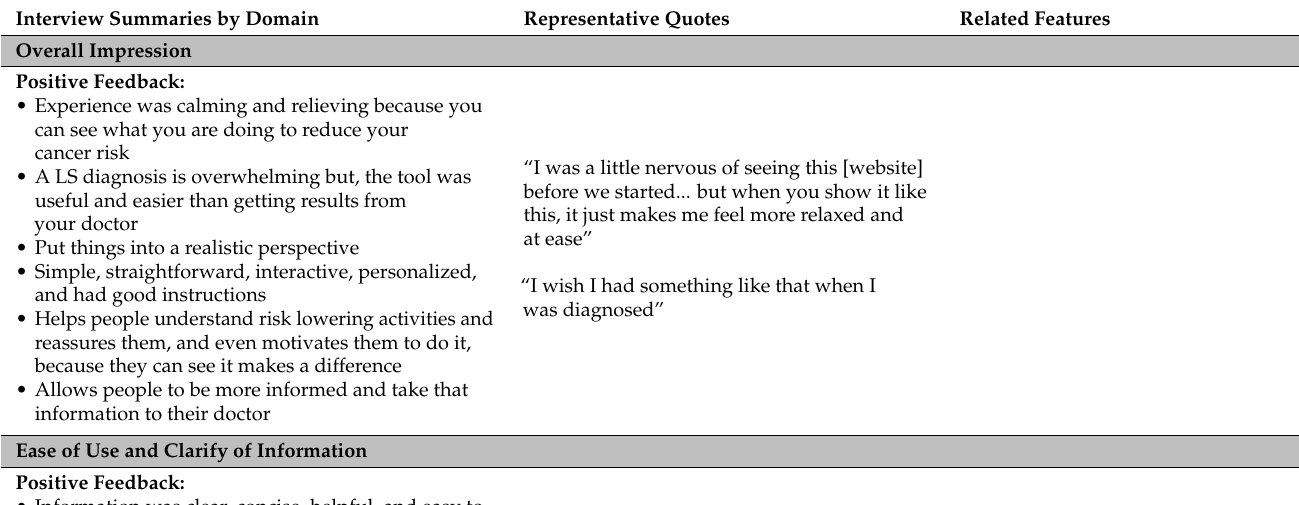
Table 5. Summary of identified domains in the cognitive